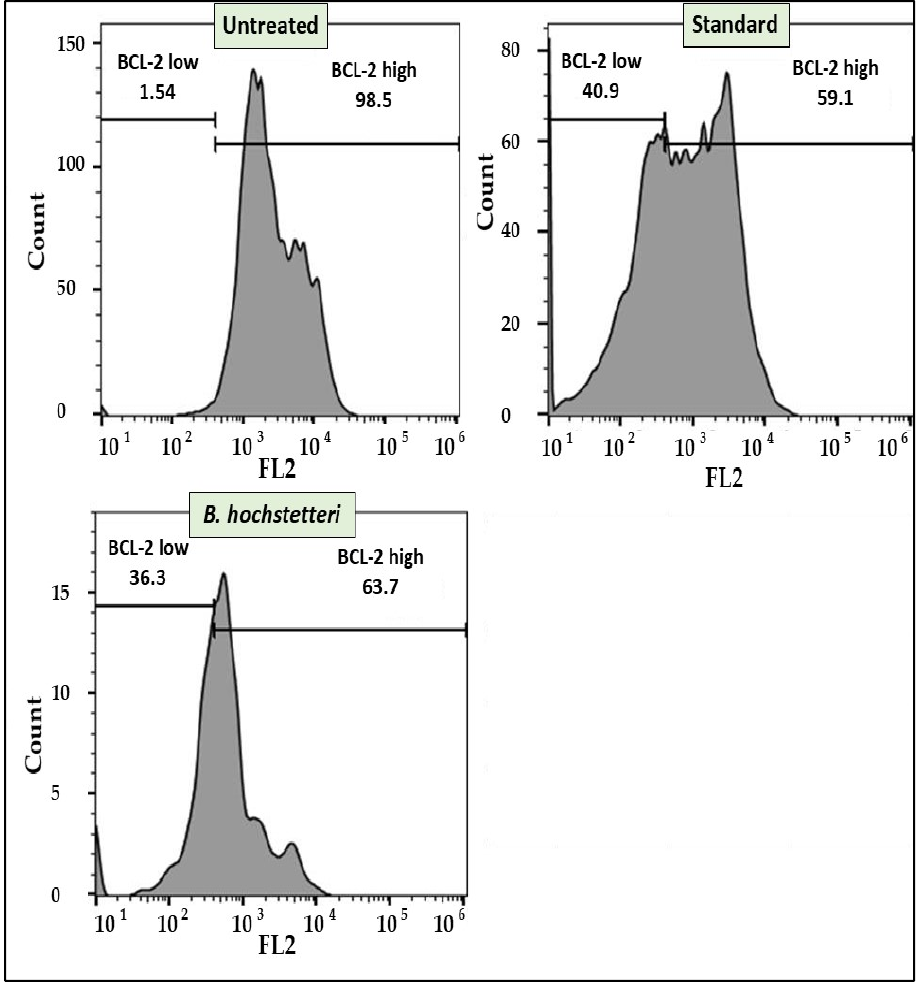
Figure 3. Flow cytometry showing the inhibitory effect of methanol extract of B. hochstetteri on the anti-apoptotic protein Bcl-2 in the lung cancer A549 cell line.